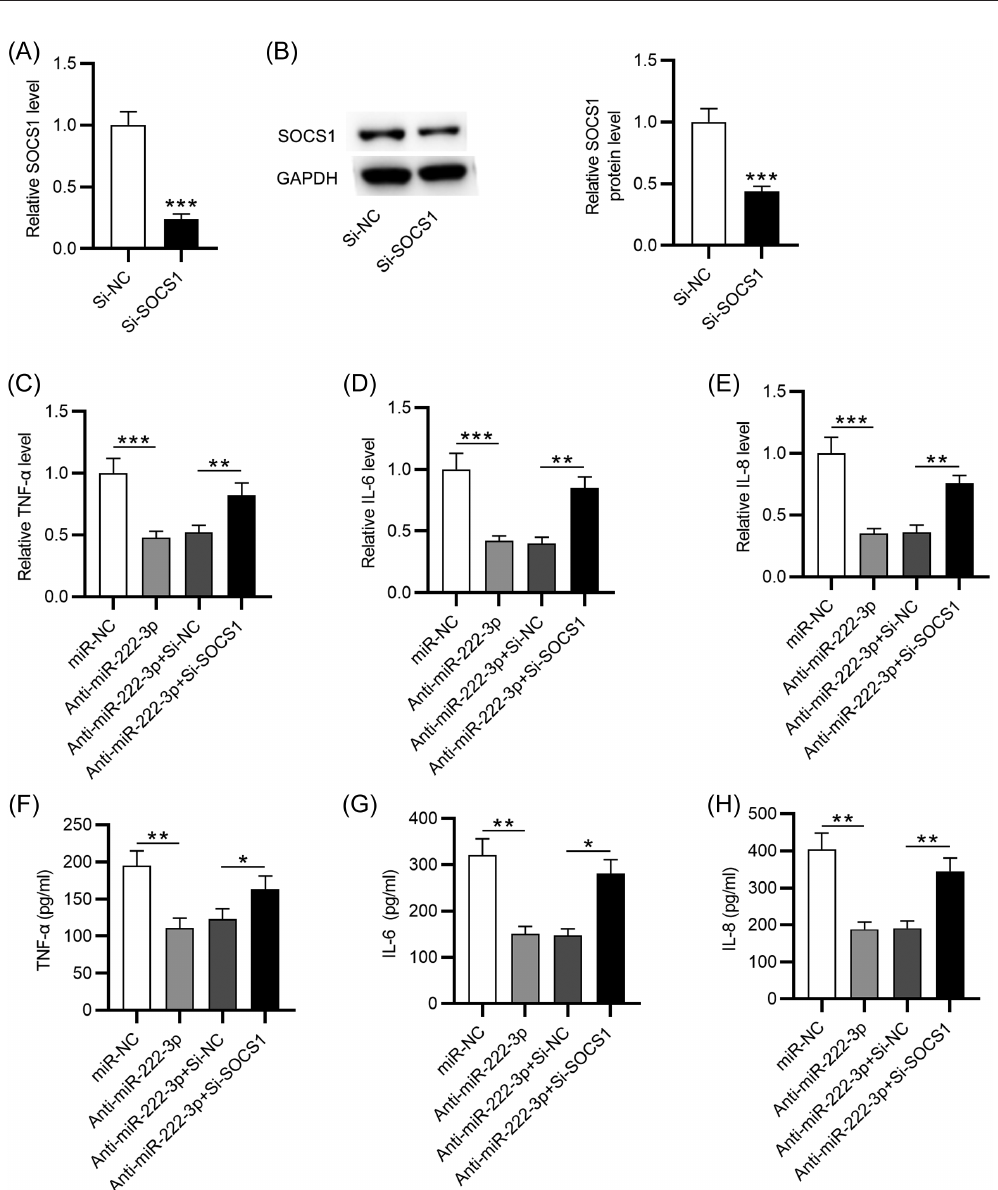
Figure 4. SOCS1 knockdown eliminates the effects of miR-222-3p inhibition. (A-B) SOCS1 mRNA and protein expression in LPS-treated RAW264.7 cells transfected with Si-SOCS1 or NC was measured by RT-qPCR and western blotting. The mRNA expression of TNF- α (C), IL-6 (D), and IL-8 (E) in LPS-treated RAW264.7 cells was detected by RT-qPCR. The concentrations of TNF- α (F), IL-6 (G), and IL-8 (H) in LPS-treated RAW264.7 cells were detected by ELISA. * P < .05, ** P < .01, *** P < .001. LPS, lipopolysaccharide, RT-qPCR, reverse transcription- quantitative polymerase chain reaction; ELISA, enzyme-linked immunosorbent Correlations Between Molecule Expression and Endoscopic Scores (UCEIS) in UC Patients